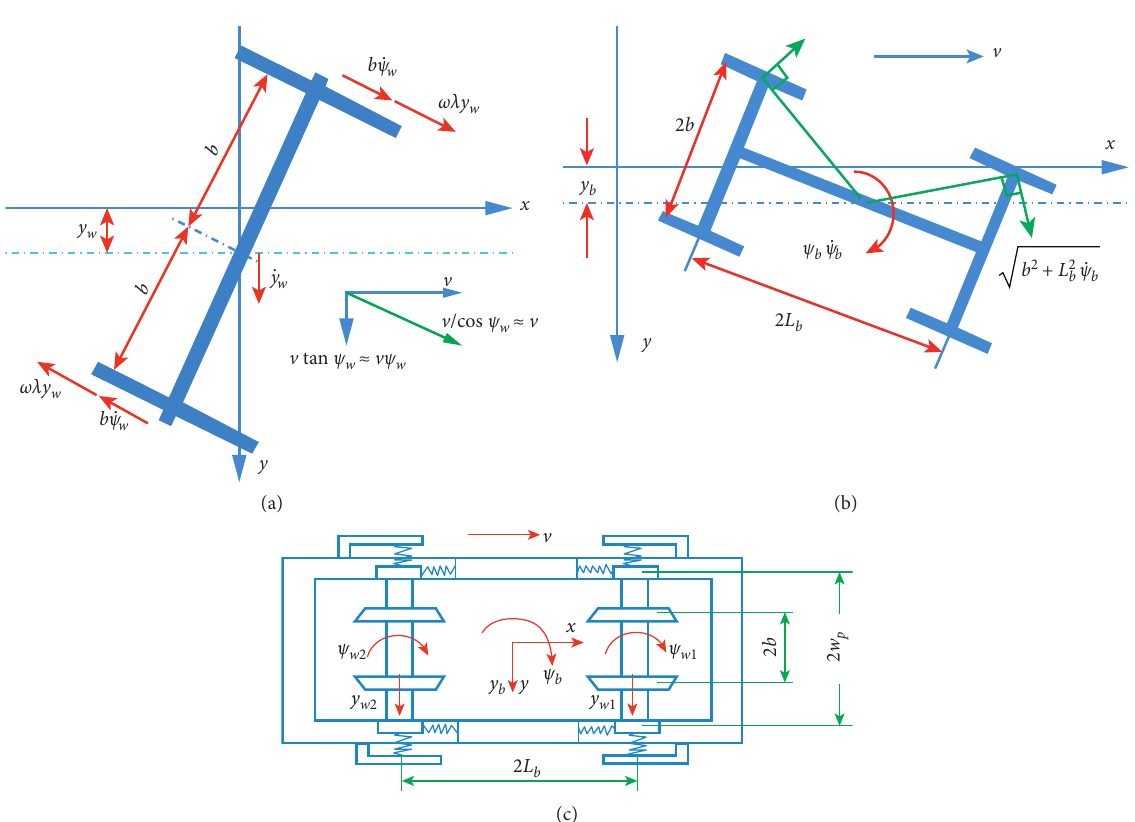
Figure 5: Simplified vehicle dynamics model for hunting study: (a) a free wheelset; (b) rigid-steering bogie; (c) flexible-steering bogie without secondary